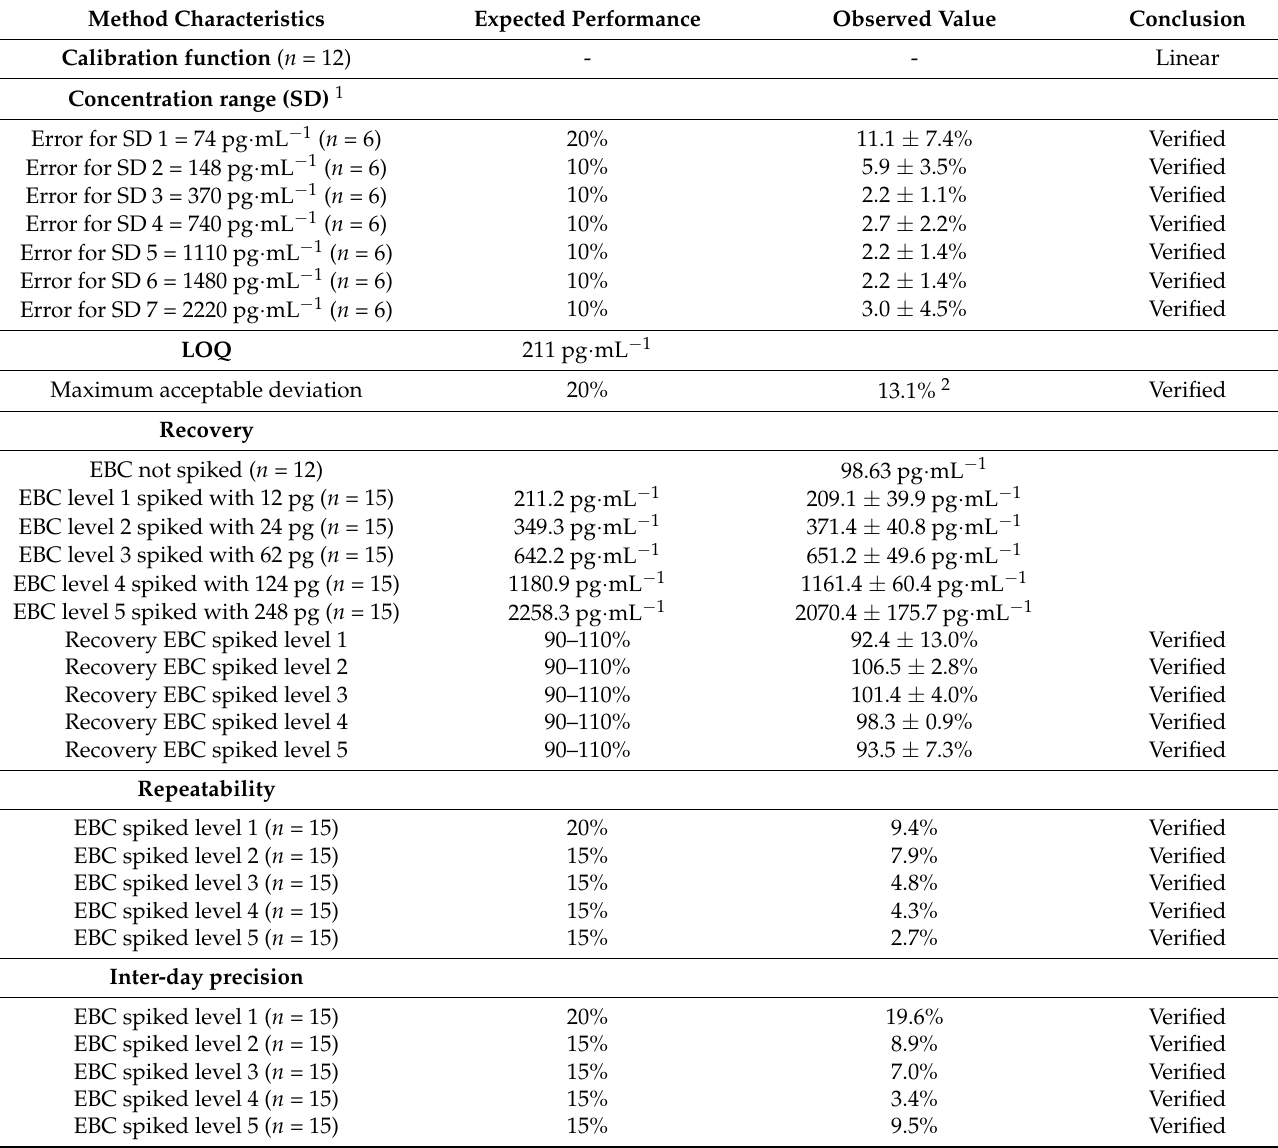
Table 1. Validation parameters determined for the analysis of MDA in EBC following the FDA/ICH